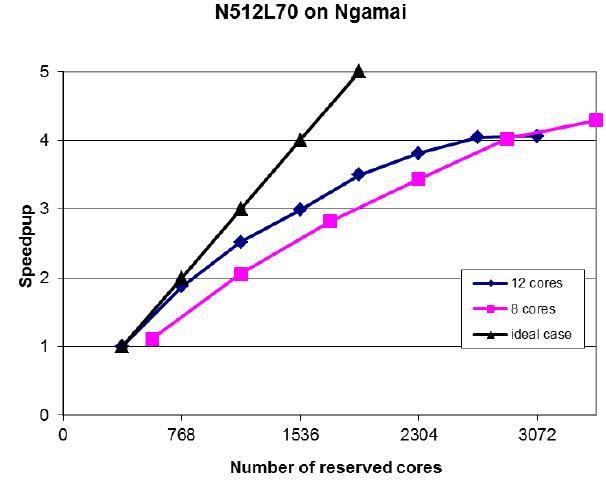
Figure 10. Speedup as a function of number of reserved cores on Ngamai. Speedup was calculated in relation to the elapsed time of 3068s obtained for a 384-core run on fully committed